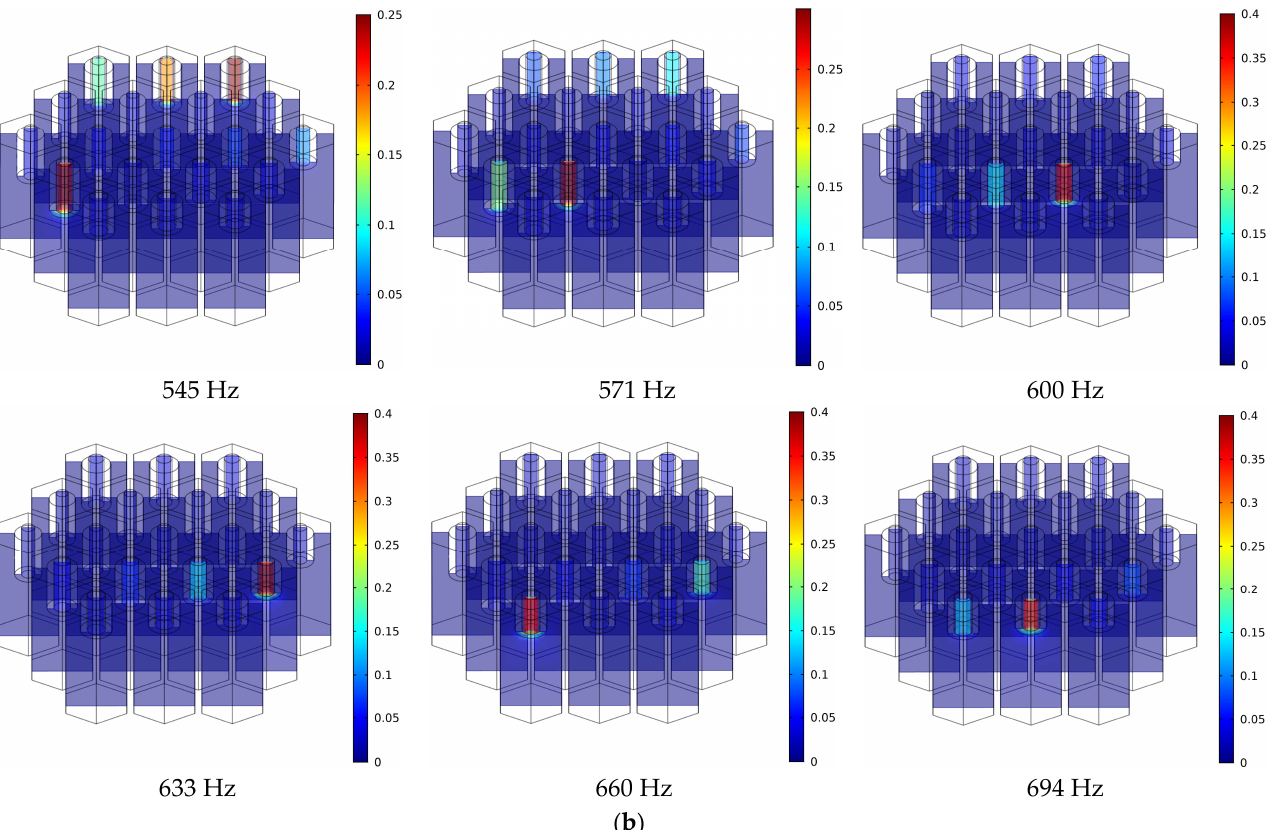
Figure 7. The optimization results. ( a ) The optimized sound absorption coefficients obtained in simulation for the acoustic metamaterial of multiple parallel hexagonal Helmholtz resonators with its corresponding nineteen single structures. ( b ) Instantaneous local velocity of corresponding absorption peaks.